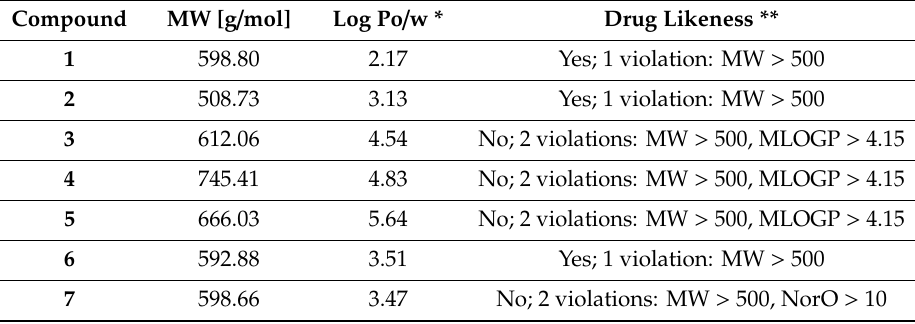
Table 1. Lipophilicity calculation and drug likeness for synthesized compounds.